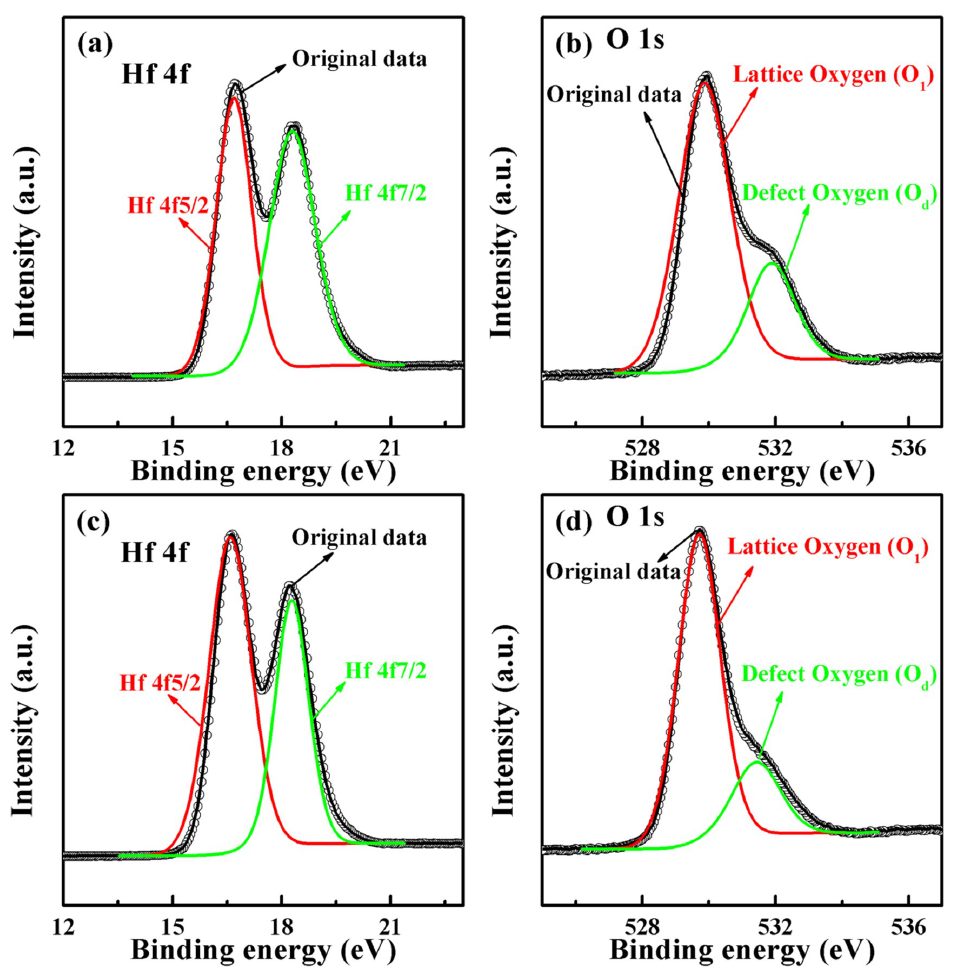
Figure 4. ( a,b ) The X-ray photoelectron spectroscopy (XPS) spectra of the S1 device; ( c,d ) the XPS Figure 4. ( a , b ) The X-ray photoelectron spectroscopy (XPS) spectra of the S1 device; ( c , d ) the XPS spectra of the S2 device; ( b , d ) show the di ff erent oxygen intensities after fitting the